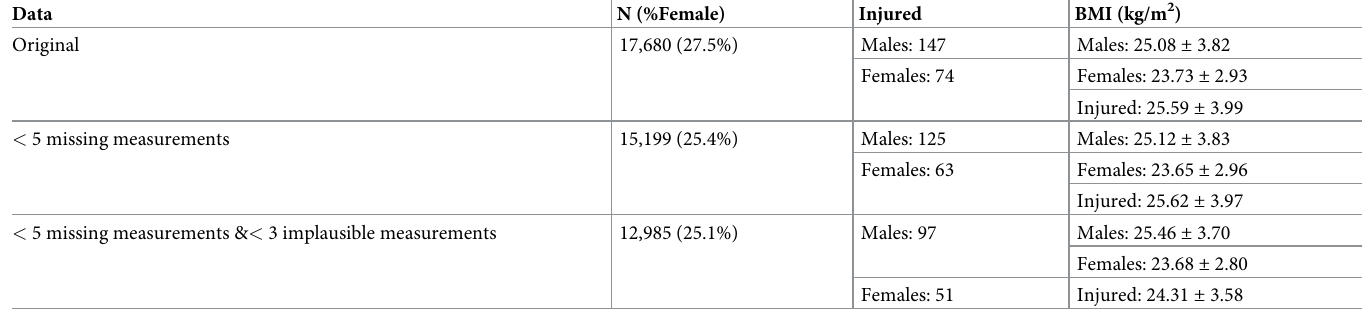
Table 1. Description of participant characteristics. The characteristics are provided from the original dataset obtained from the scanner, the reduced dataset after elimi- nating observations that included more than five missing measurements and the final reference dataset after removing observations with three or more implausible